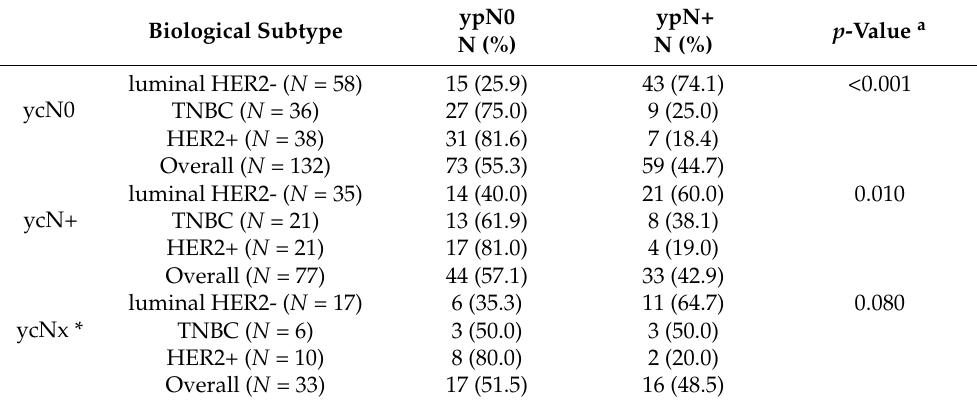
Table 1. Pathological lymph node status after NAST according to clinical nodal status after NAST and biological